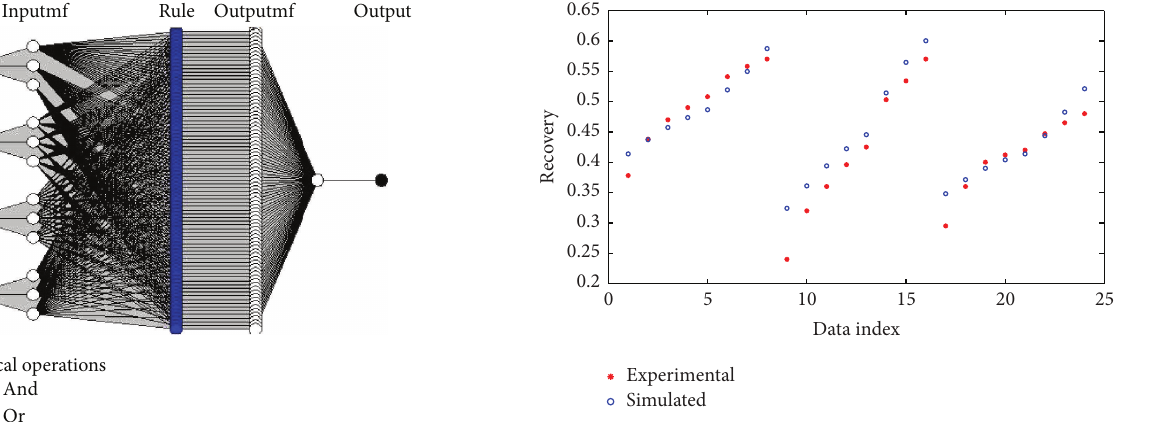
Figure 3: Performance of ANN for test